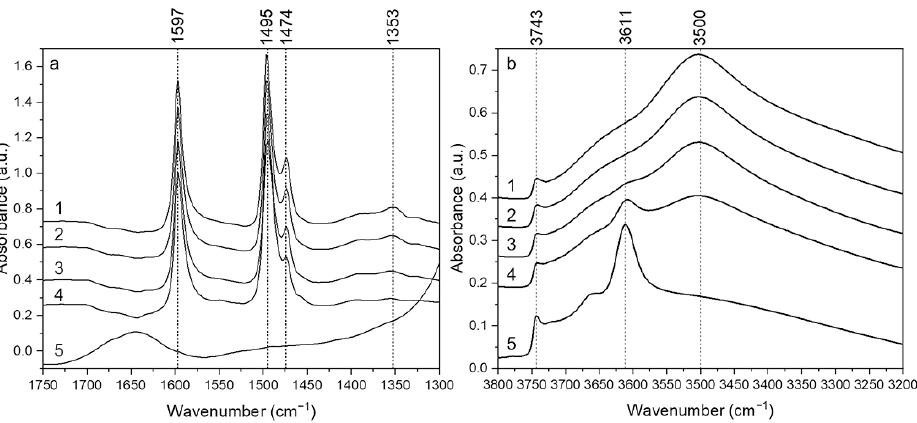
Figure 6. ( a ) Aromatic region of the infrared spectra of adsorbed phenol with ZSM-5 support subtracted and normalized to the 1495-band maximum; ( b ) hydroxyl region of the infrared spectra of ZSM-5 before and after exposure to phenol. Traces taken after being heated to the following temperatures: 50 °C (1), 150 °C (2), 250 °C (3) and 350 °C (4) with calcined ZSM-5 prior to dosing included for comparison (5).